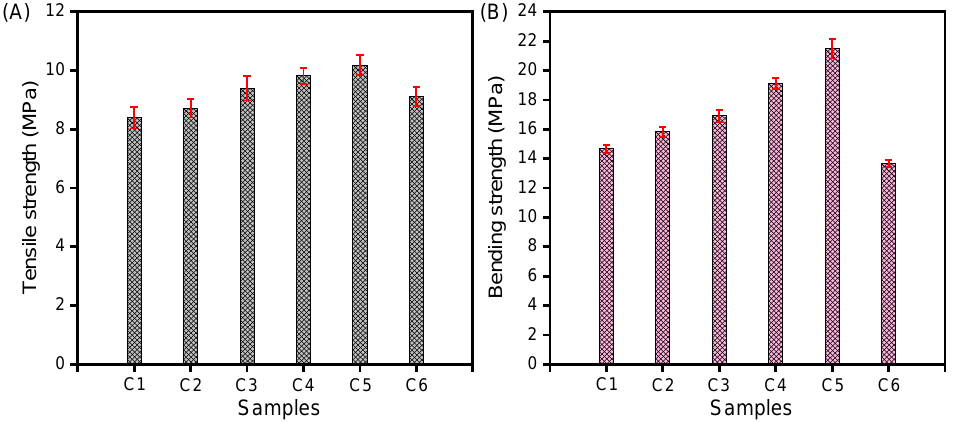
Figure 4. Tensile strength ( A ) and bending strength ( B ) of CNT-PE-EPDM/EG-based PCMs.